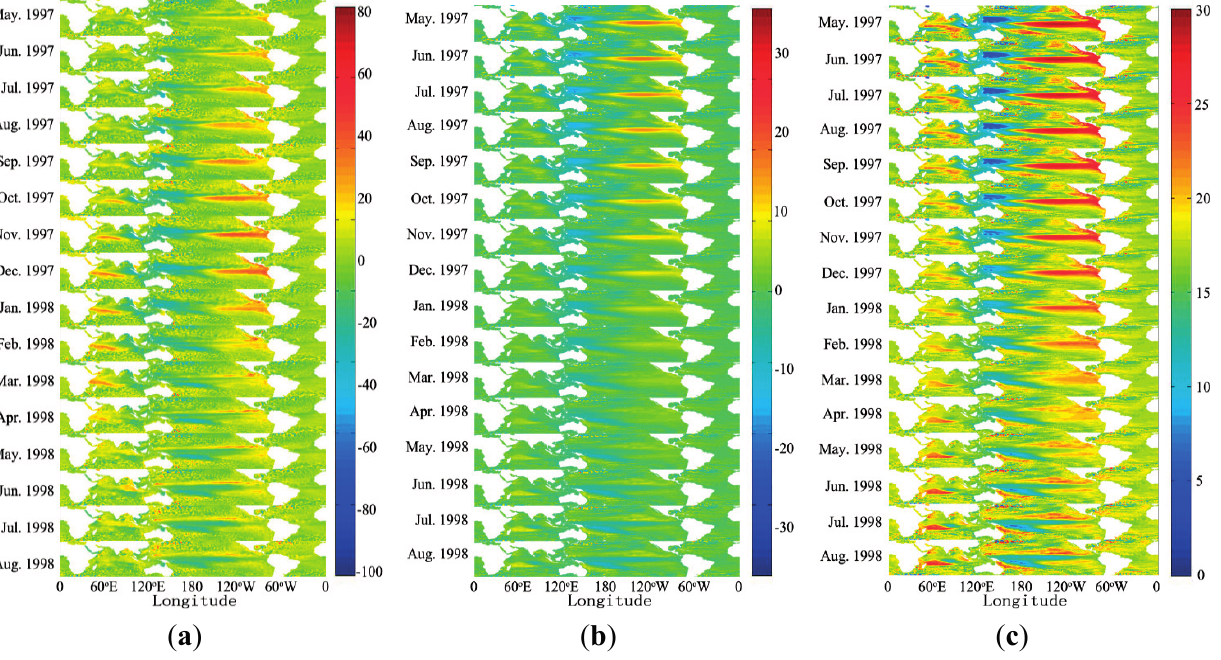
Figure 9. The spatio-temporal evolution of the D5 component during the 1997–1998 El Niño: